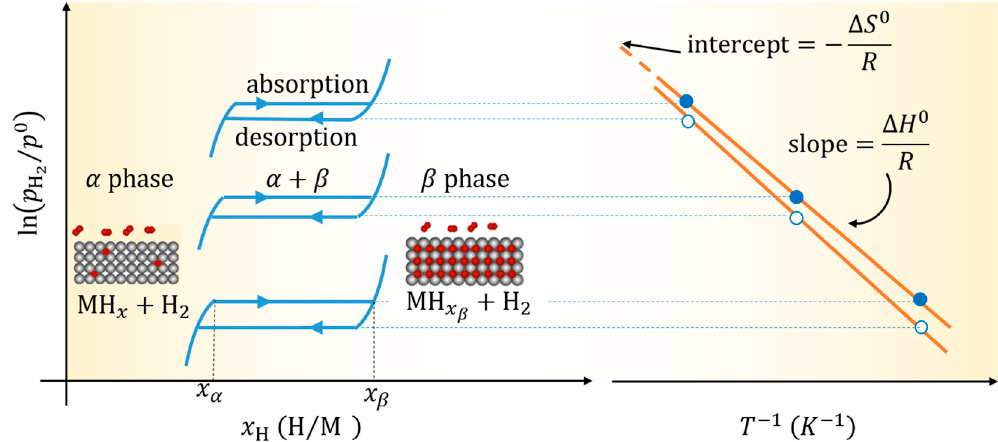
Figure 1. Schematic illustration of the thermodynamics of hydride formation and decomposition. The left part shows pressure-composition isotherms (PCIs) recorded at different temperatures; from the temperature dependence of the plateau pressures for H absorption and desorption, reported in the van ‘t Hoff plot to the right, the standard enthalpy and entropy of the reaction are determined.